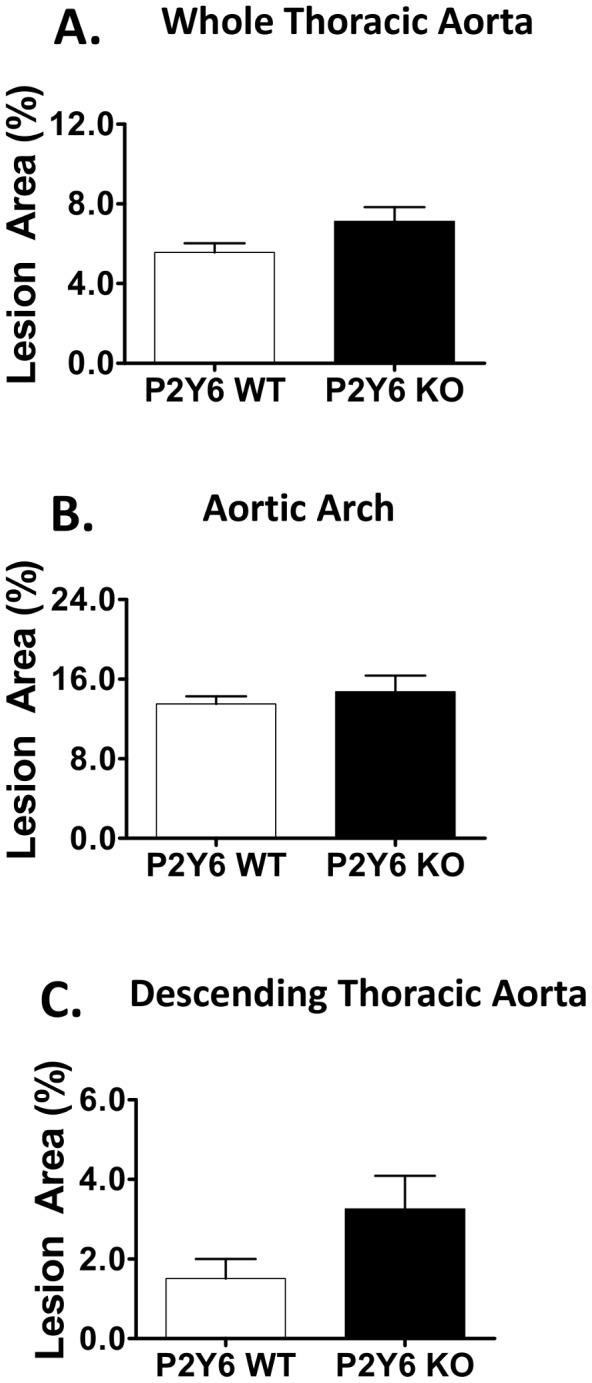
Accelerated Atherosclerosis development with Angiotensin II infusion.Atherosclerosis development measured in the aorta with oil red O. A) Quantification of en face lesion area in the thoracic aorta (ascending aorta to the diaphragm). Regional atherosclerosis in B) aortic arch and C) descending thoracic aorta segments. Group sizes: n = 9 P2Y6 WT mice; n = 14 P2Y6 KO mice. The fold change in P2Y6 lesion area is given relative to P2Y6 wild type levels. Not significant, n.s.